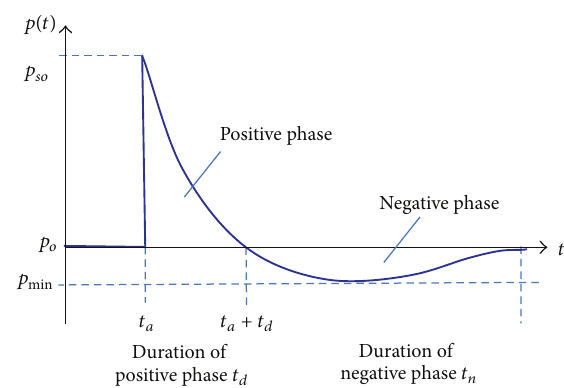
Figure 3: Diagram of pressure variation as a function of